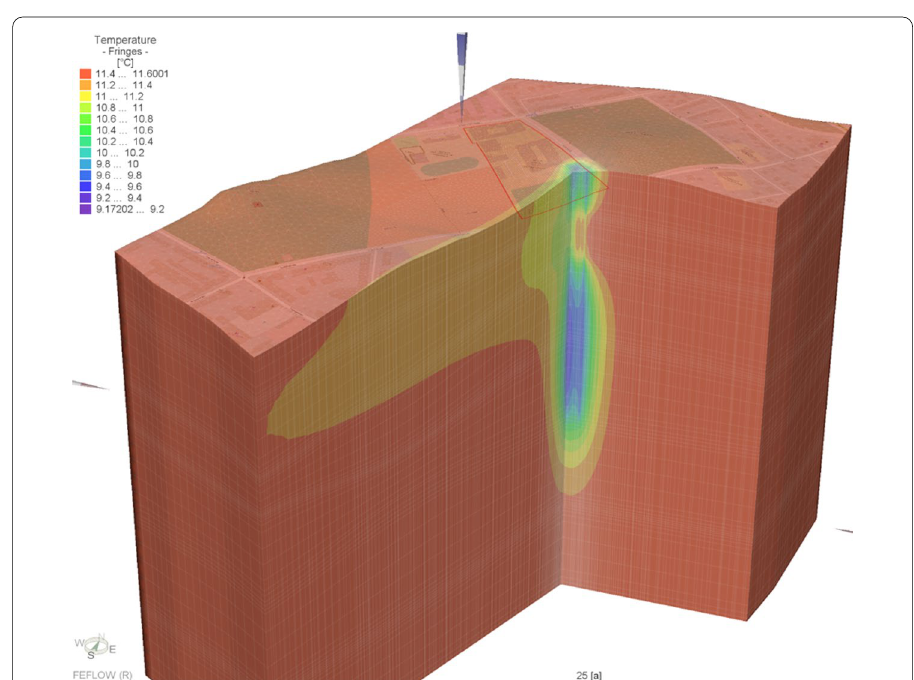
Fig. 6 3D model cut of the Berlin area with its temperature contour after a 25 years simulation (generated with FEFLOW version